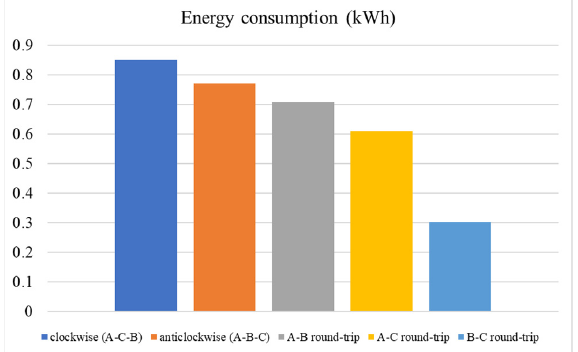
Energies 2022 , 15 , x FOR PEER REVIEW Figure 13. Energy consumption comparison of the multi-point routes. Figure 13. Energy consumption comparison of the multi-point routes. Figure 13. Energy consumption comparison of the multi-point routes.